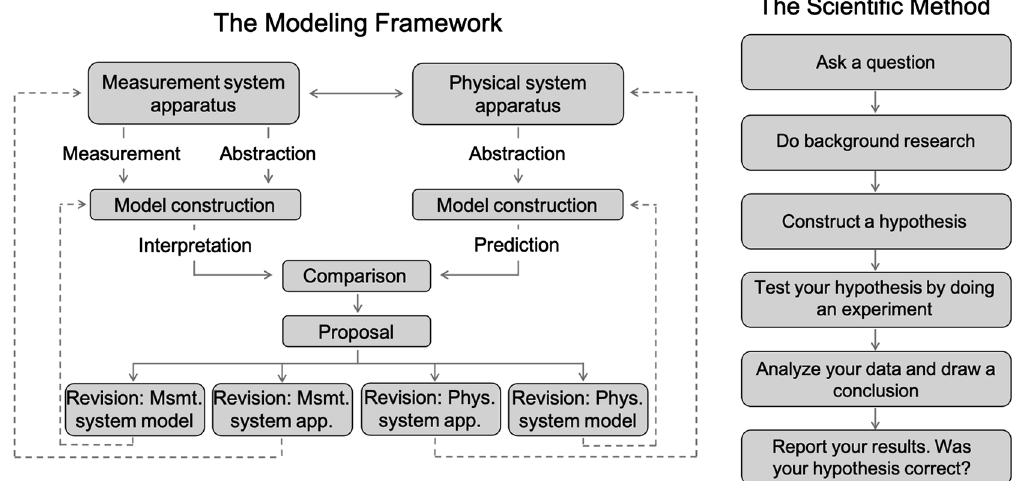
FIG. 2. Diagrams shown to students during the interview. On the left is the Experimental Modeling Framework (a simplified version of the full framework presented in Fig. 1). On the right is a linear scientific method, a common depiction of the process of